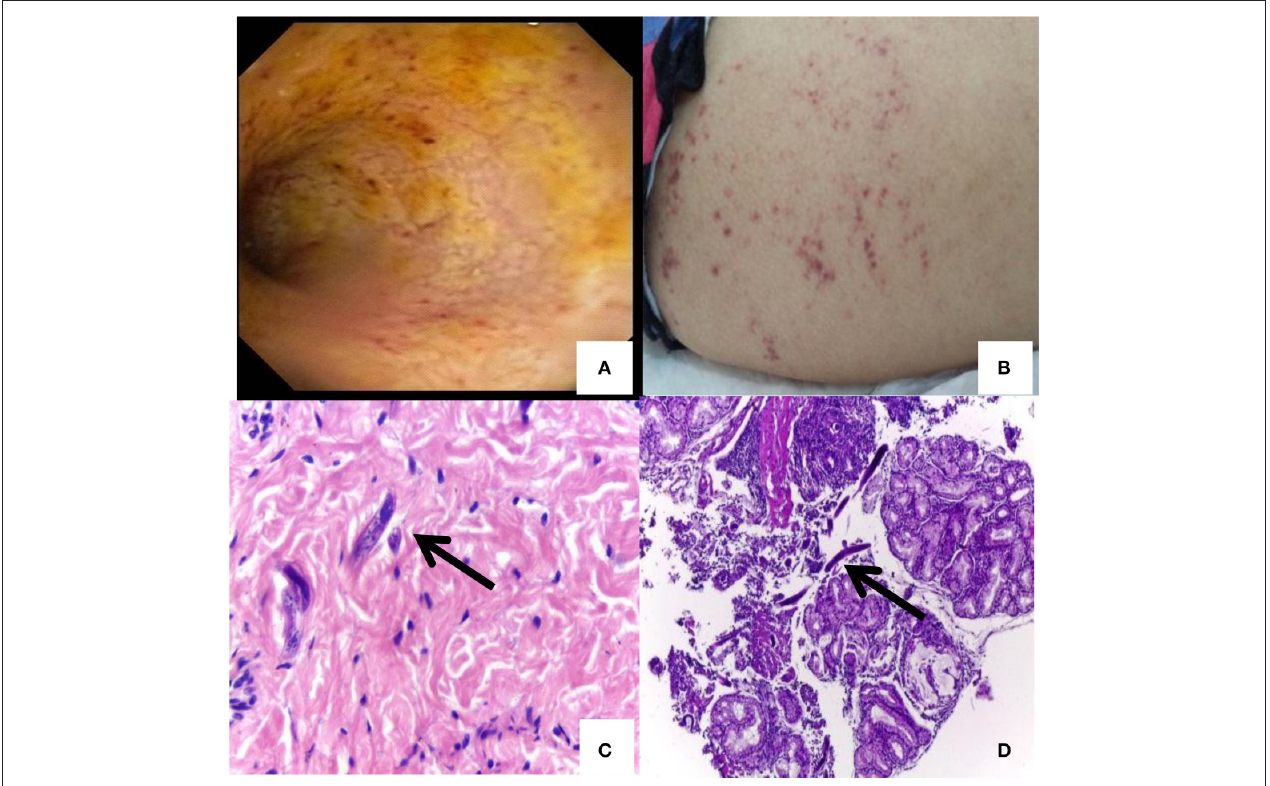
FIGURE 1 | Petechial lesions and Strongyloides stercoralis larvae detection: (A) A push enteroscopy showing signs of severe duodenal and jejunal atrophy mucosa with multiple petechial lesions. (B) Abdominal skin rash and petechiae of disseminated Strongyloides . (C) Strongyloides larvae in skin. (D) Strongyloides larvae in